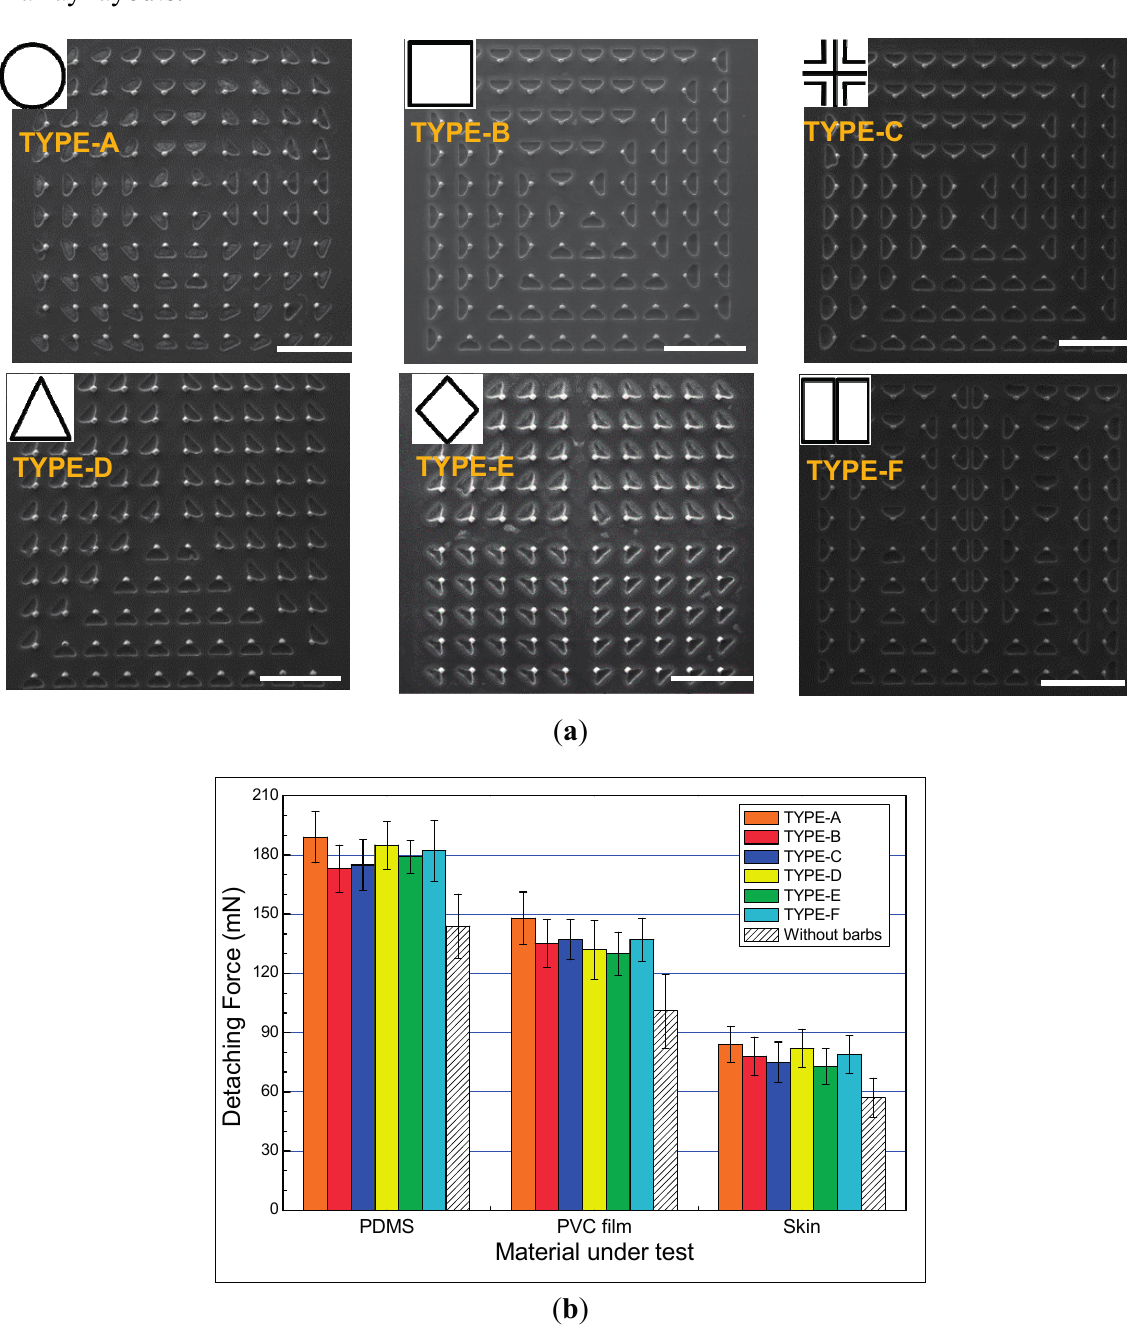
Figure 11. ( a ) SEM images of tip arrays with different array layouts (155 μ m tip length). The scale bar is 1 mm; ( b ) Measured detaching forces of the tip arrays with different array